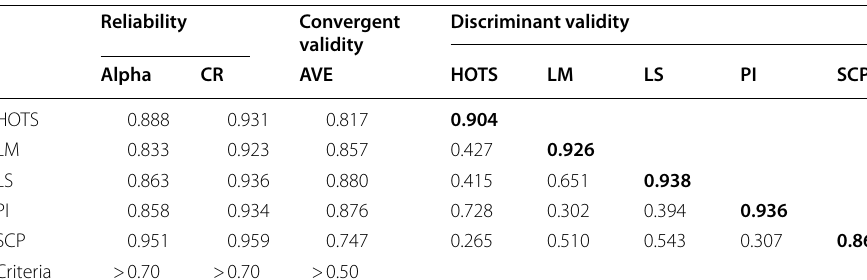
Table 1 Results of the measurement model